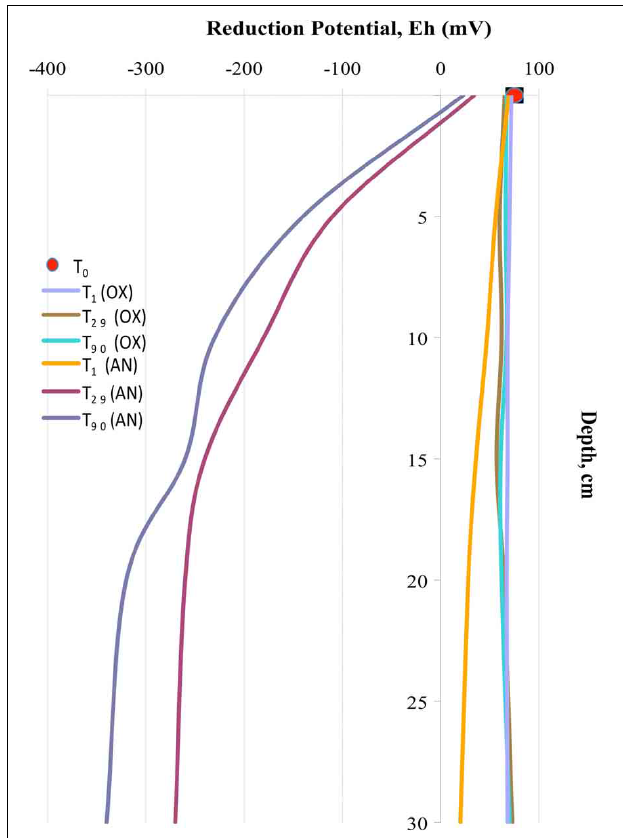
FIGURE 3 | Reduction potential (E h ) measured in external anaerobic sediments (AN) and in internal aerated sediments (OX) during 3 months of